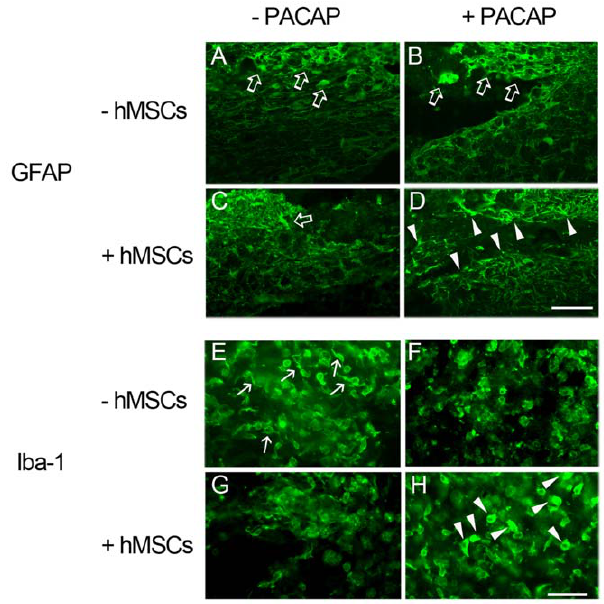
Figure 5. Immunofluorescence of GFAP and Iba-I in the injured spinal cord tissues. The injured spinal cord tissue sections were collected at day 31 after SCI. The longitudinal tissue sections were subjected to immunofluorescence for GFAP (A–D) and Iba-1 (E–H). GFAP positive hypertrophic cells (open arrows) were observed in the areas proximal to the lesion center of the injured spinal cord treated with vehicle (A), PACAP (B), or hMSCs (C), while GFAP positive stellated cells (arrowheads) were found at the periphery to the lesion center treated with hMSCs and PACAP (D). Amoeboid-shaped Iba-1 positive microglia/macrophages (arrowheads) were observed in the injured spinal cord proximal to the lesion center with combinatorial treatment by hMSCs and PACAP (H). Unipolar Iba-1 positive microglia (arrows in E) are present around the lesion center of the spinal cord treated with vehicle. Scale bars, 100 m m (A–D) and 50 m m